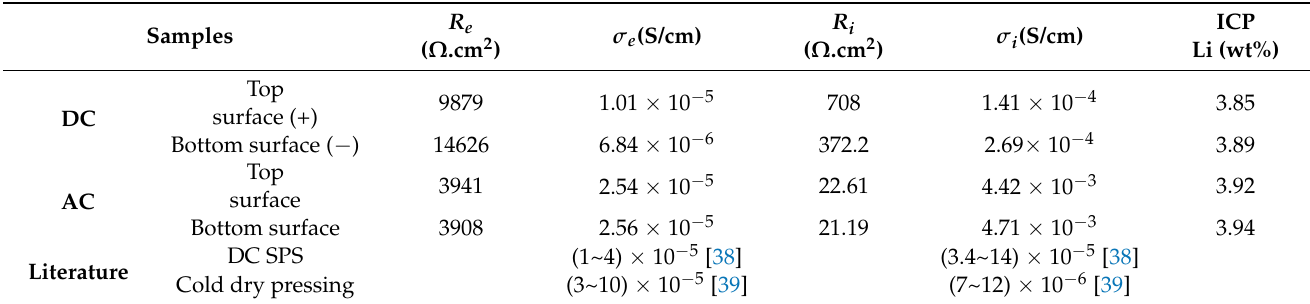
Table 1. The electronic ( σ e ) and ionic ( σ i ) conductivity of the LiFePO 4 samples and ICP-AES Li content of LFP materials. Literature references’ values, processing route and comparative values are also